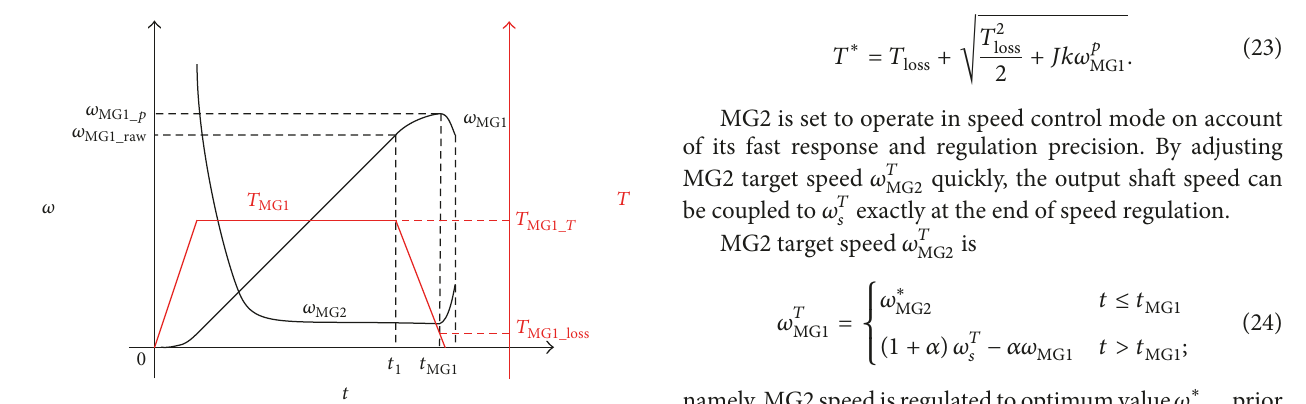
Figure 5: Variables changing curves in upshift speed regulation 1.